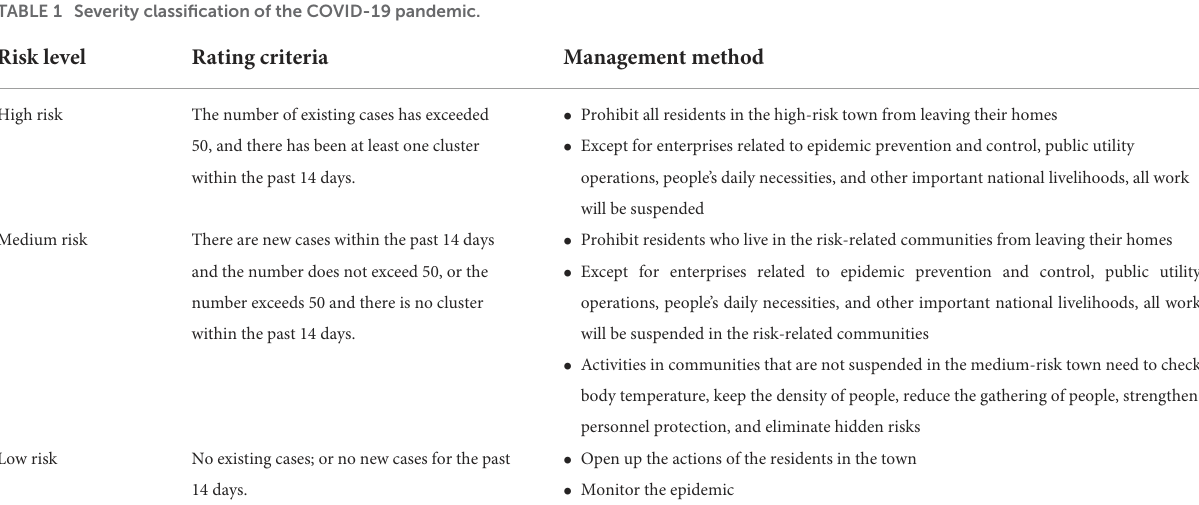
TABLE 1 Severity classification of the COVID-19